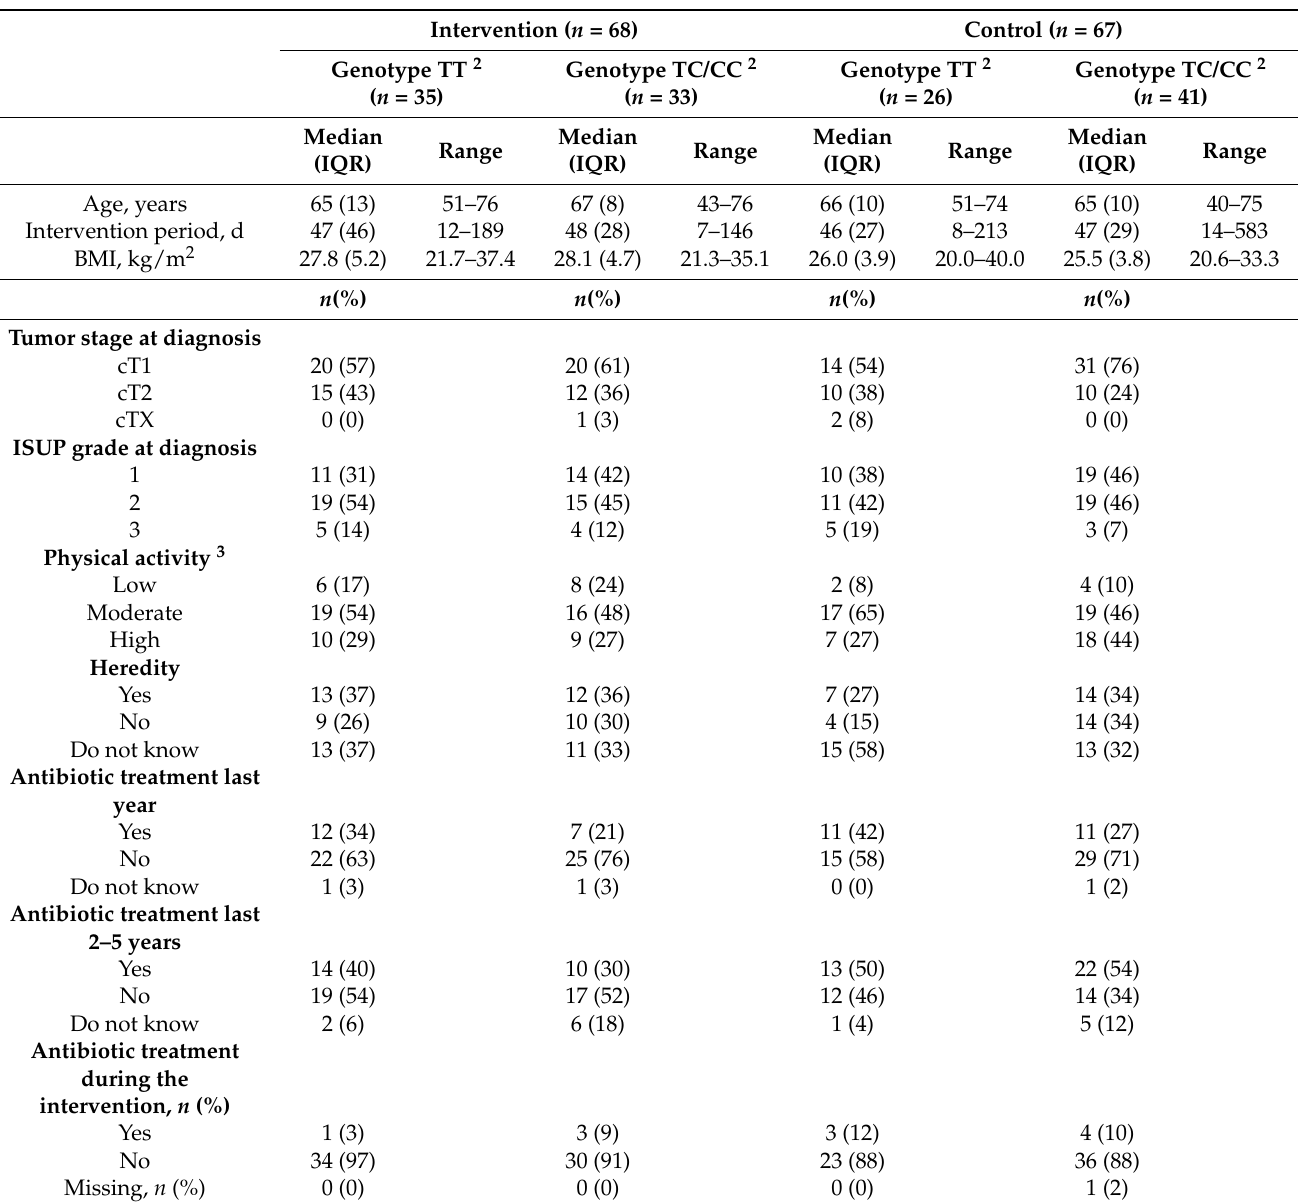
Table 1. Demographics of the patients included in the PRODICA 1